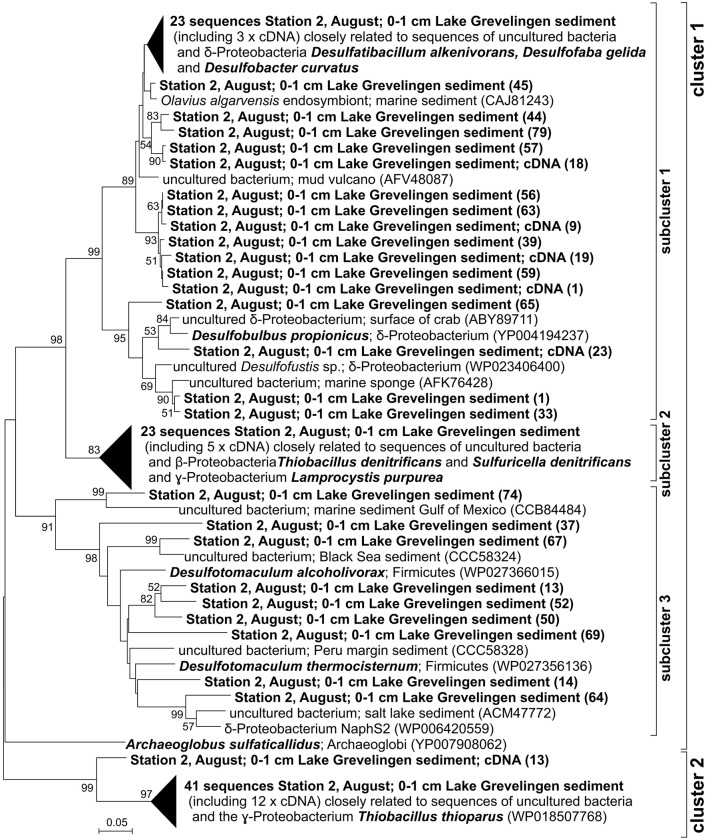
Phylogenetic tree of partial aprA gene sequences of sulfur-oxidizing and sulfate-reducing bacteria (SOB and SRB) retrieved in this study (86 DNA sequences recovered by amplification (PCR) and 21 cDNA sequences recovered by amplification (qPCR) and cloning from sediments (0–1 cm) of station S2 in August) and closest relatives (bold: our sequences and closest known relatives); the scale bar indicates 25% sequence divergence.